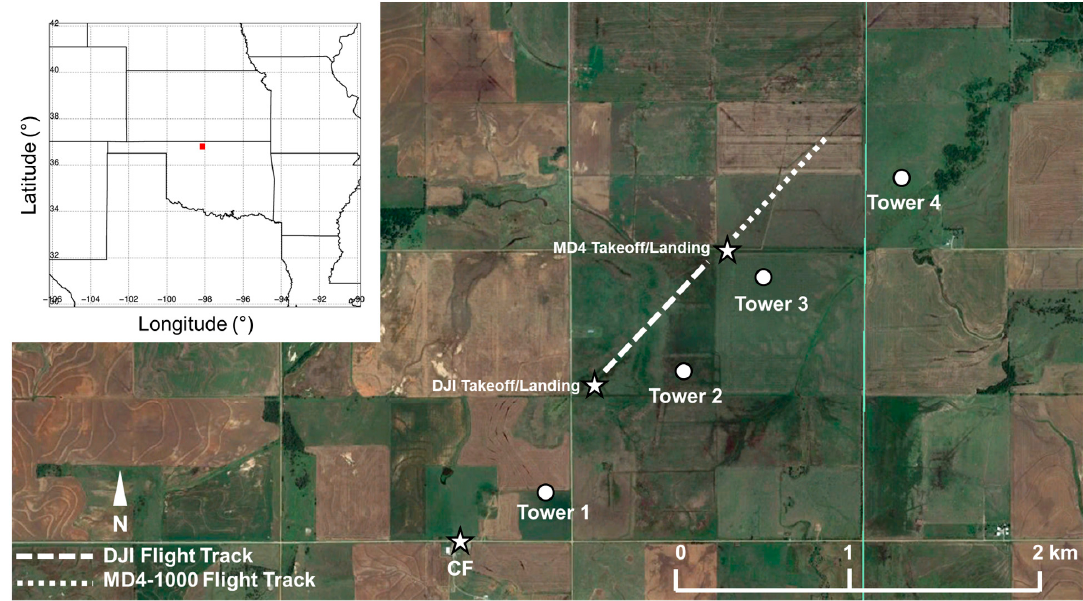
Figure 2. Relative location of flights of the DJI S-1000 (white dashed line) and MD4-1000 (white dotted line) sUAS to the four micrometeorological towers and central facility (CF) during LAFE. Image is courtesy of Google Earth. Inset map at the top left shows location of study site (red box) in north central Oklahoma.